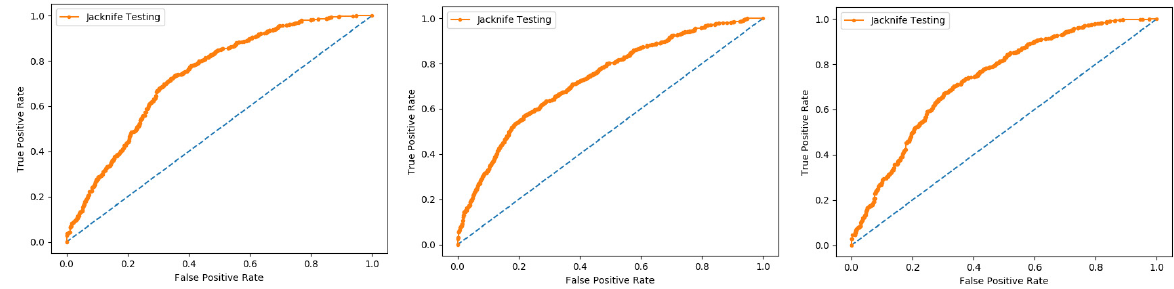
Figure 8. Jackknife Random Forest ROC curve.